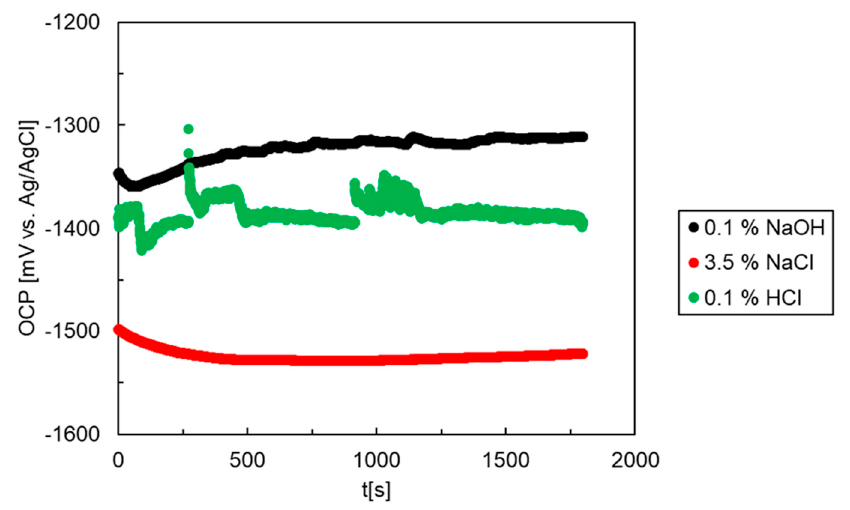
Figure 5. Open circuit potentials of the Mg 2 Sn alloy in aqueous NaOH (0.1 wt.%), NaCl (3.5 wt.%) and HCl (0.1 wt.%) solutions.